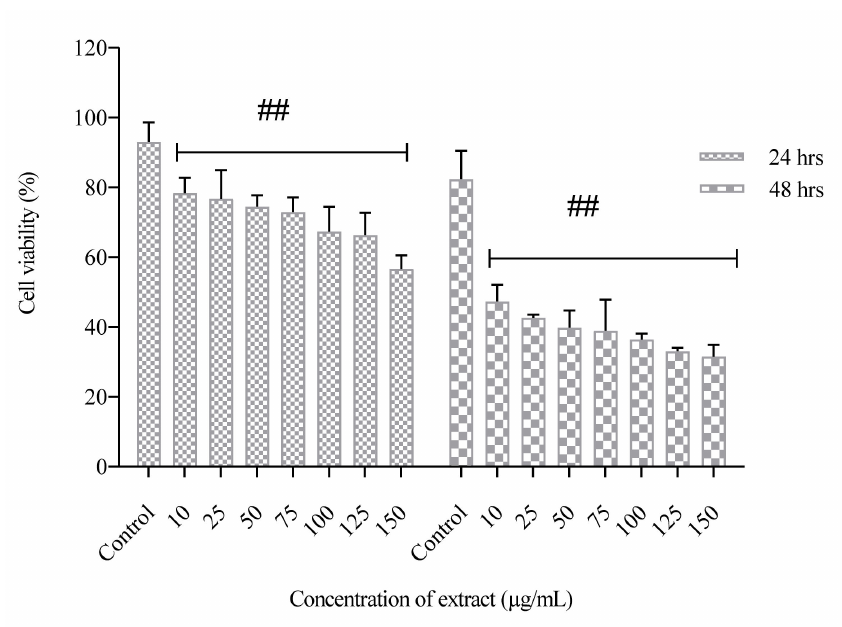
Figure 2. Cell viability of human breast cancer cells (MCF-7) treated with PUFA-rich extracts from Chlorella sp. S14. Bars represent mean ± SEM. Values are statistically different at ## p < 0.05 vs. control.